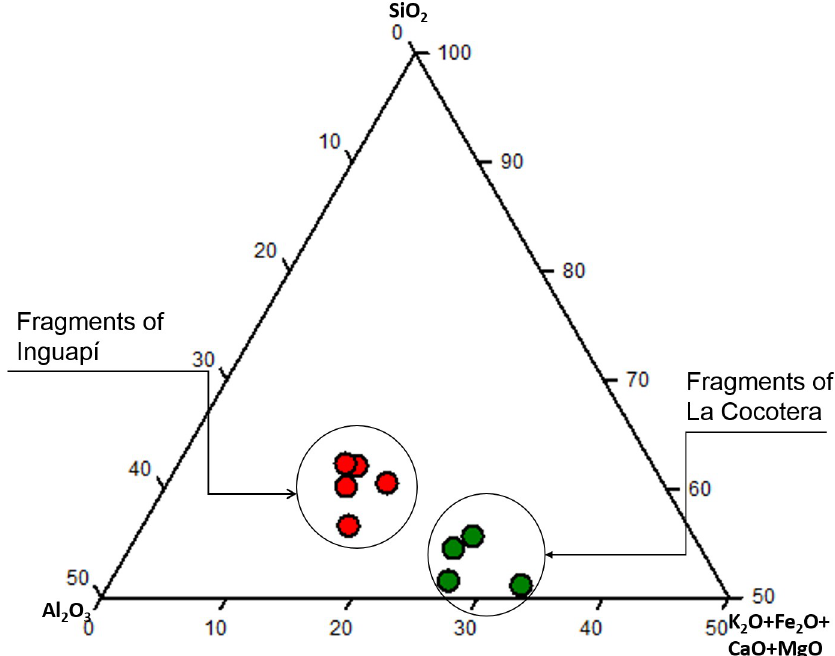
Fig 4. Ternary composition diagram of the analyzed samples. The bulk concentrations of alumina, silica and the sum of CaO + MgO + K 2 O and Fe 2 O 3 were plotted.